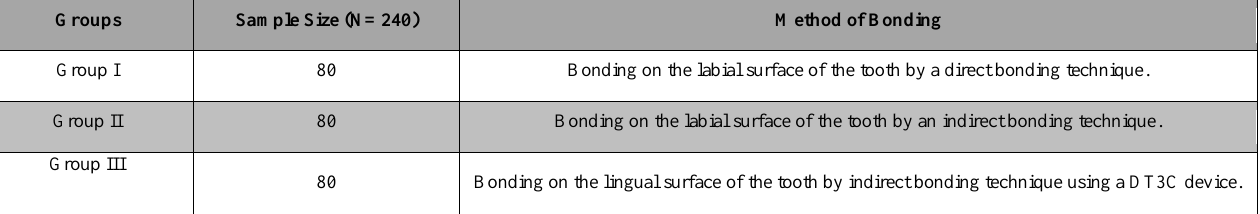
Table 1. Distribution of sample in groups.